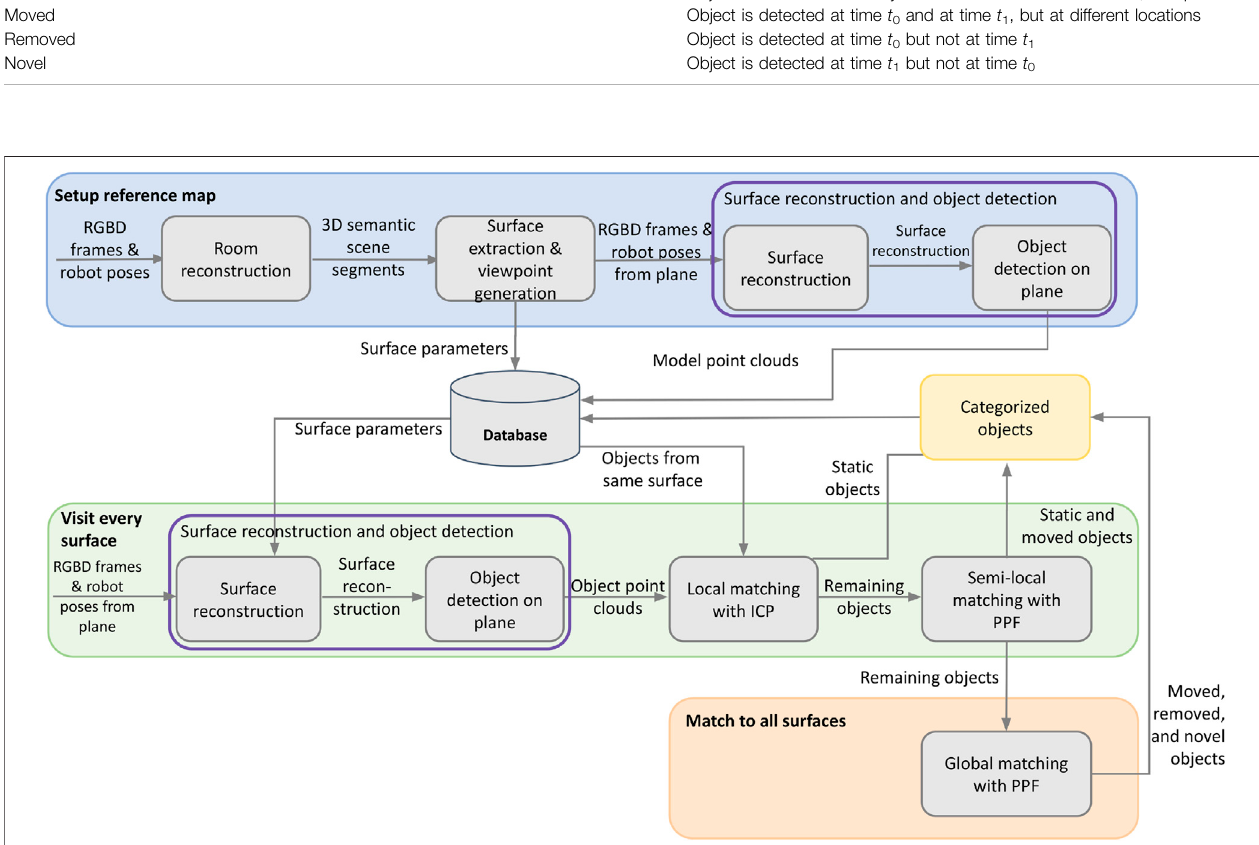
Frontiers in Robotics and AI |